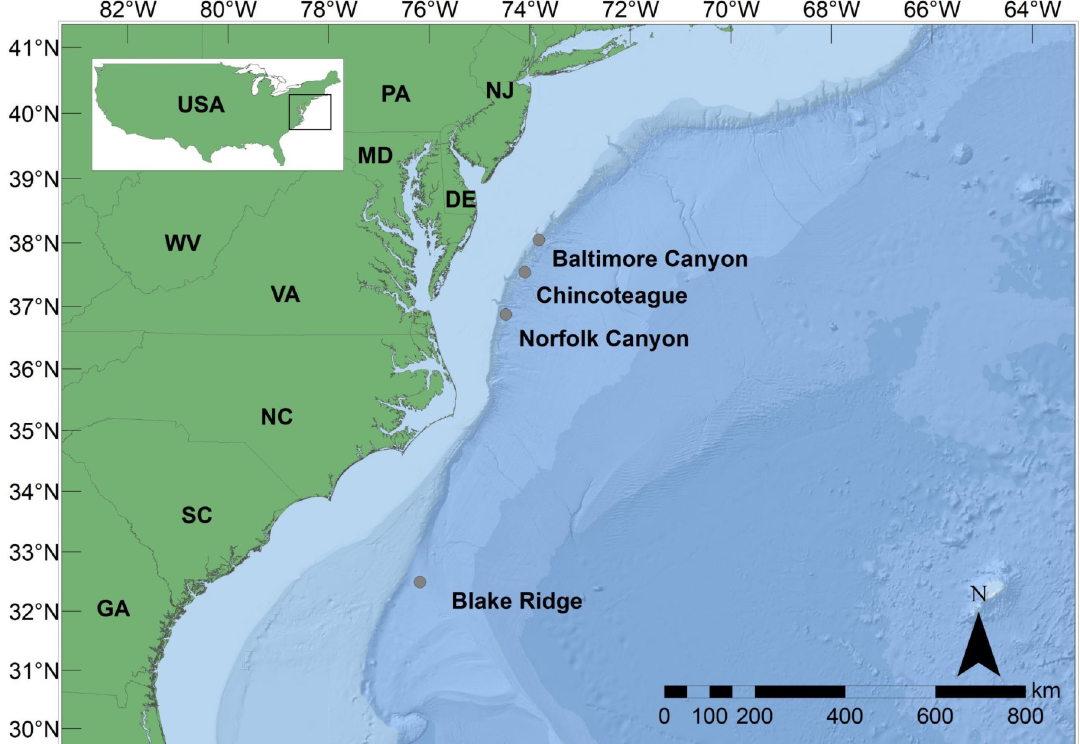
Fig 1. Map of sampling locations of Bathymodiolus spp. in this